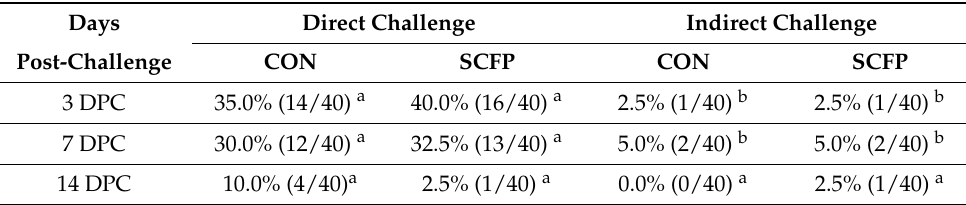
Table 4. Prevalence and number of SE-positive ovaries in pullets directly challenged and indirectly exposed to the challenge strain of